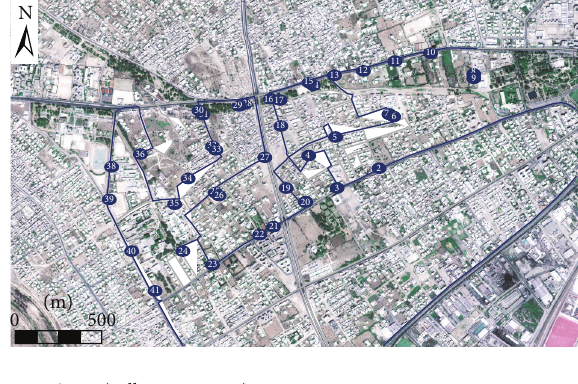
Figure 8: Optimized route for Scenario